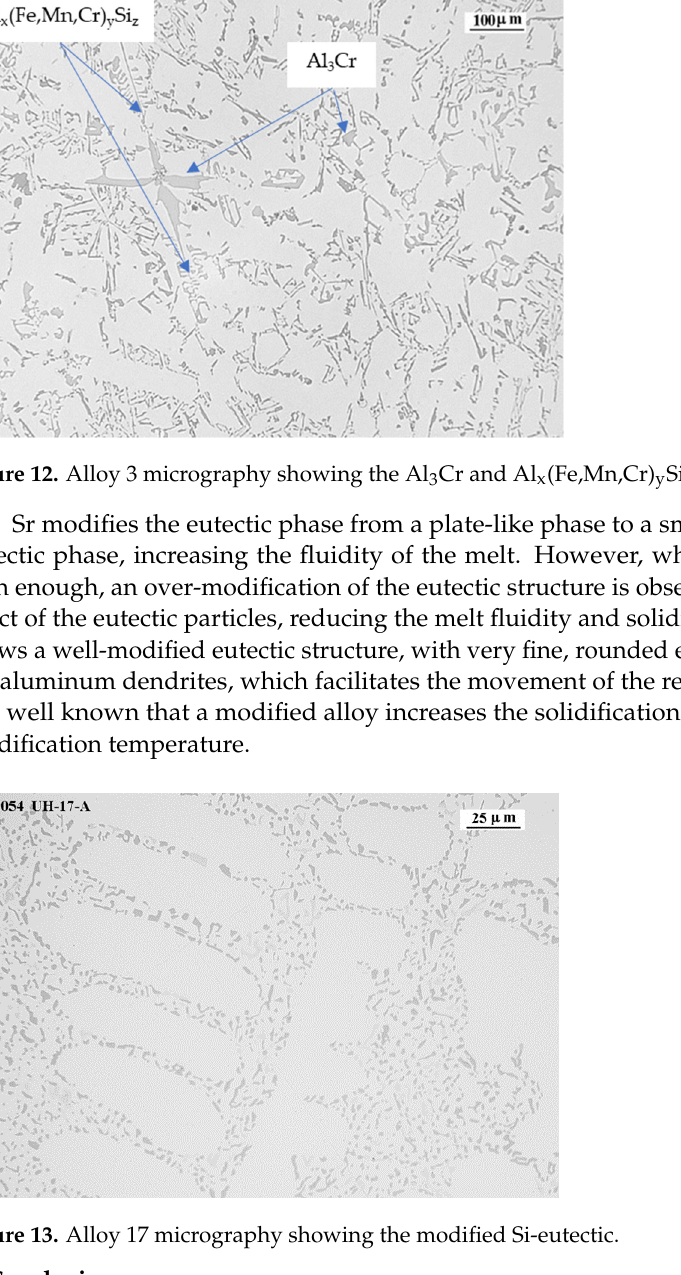
Figure 13. Alloy 17 micrography showing the modified Si-eutectic.